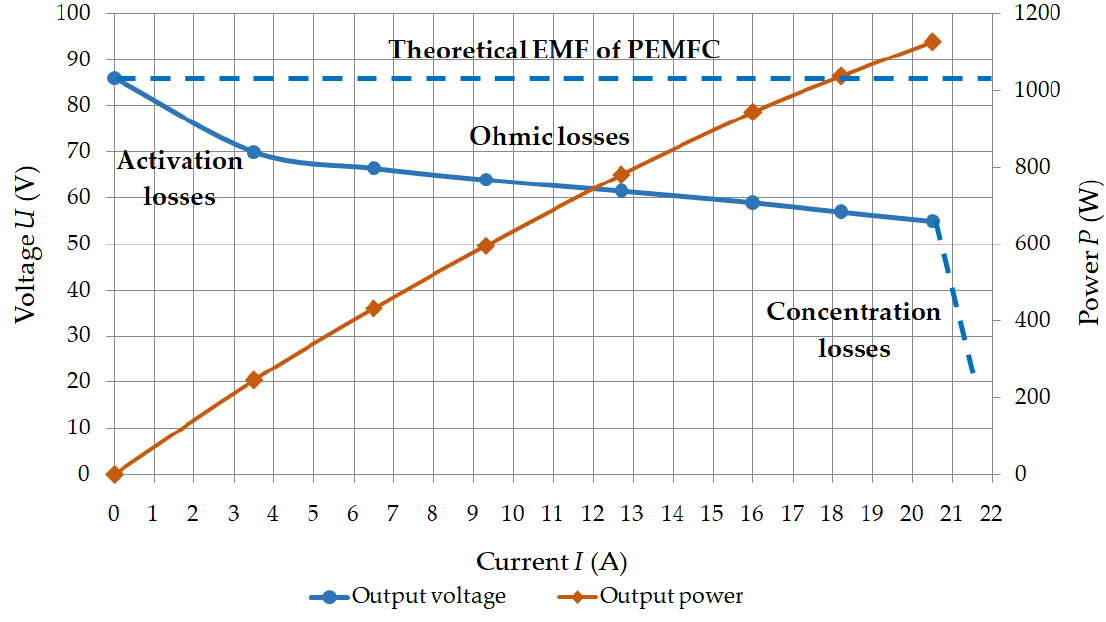
Figure 1. Nominal V–I curve of PEMFC used in HEC.